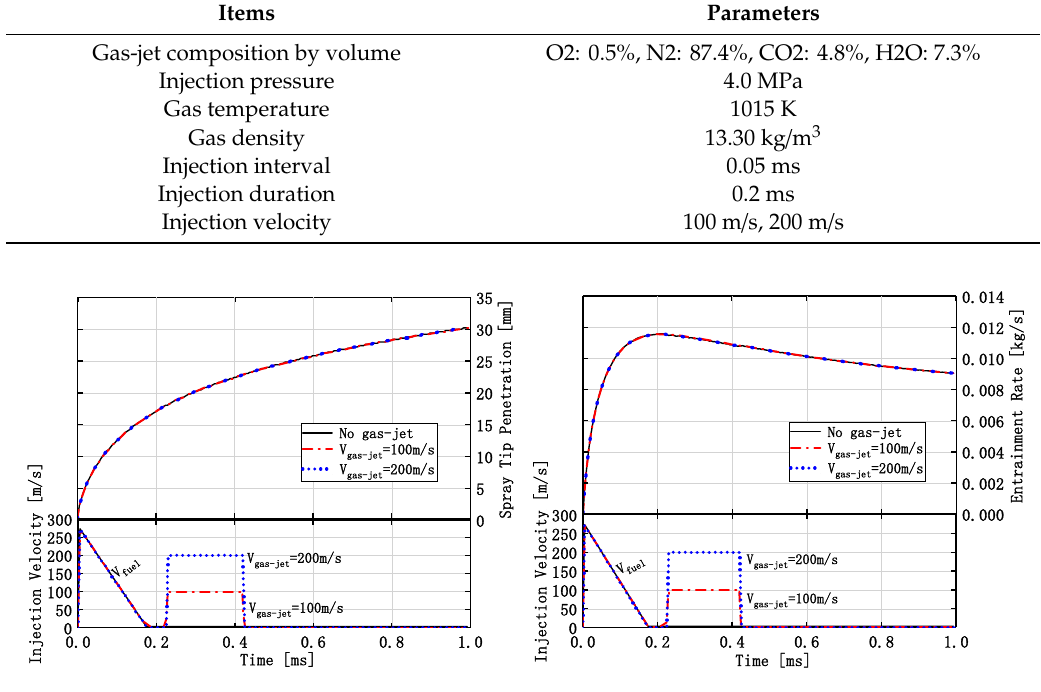
Figure 13. Spray tip penetrations ( a ) and entrainment rates ( b ) of the ramping-down injection with gas-jet and the ramping-down injection without gas-jet (black solid lines: ramping-down injection without gas-jet; red chain lines: ramping-down injection with gas-jet of 100 m/s; blue dotted lines: ramping-down injection with gas-jet of 200 m/s).